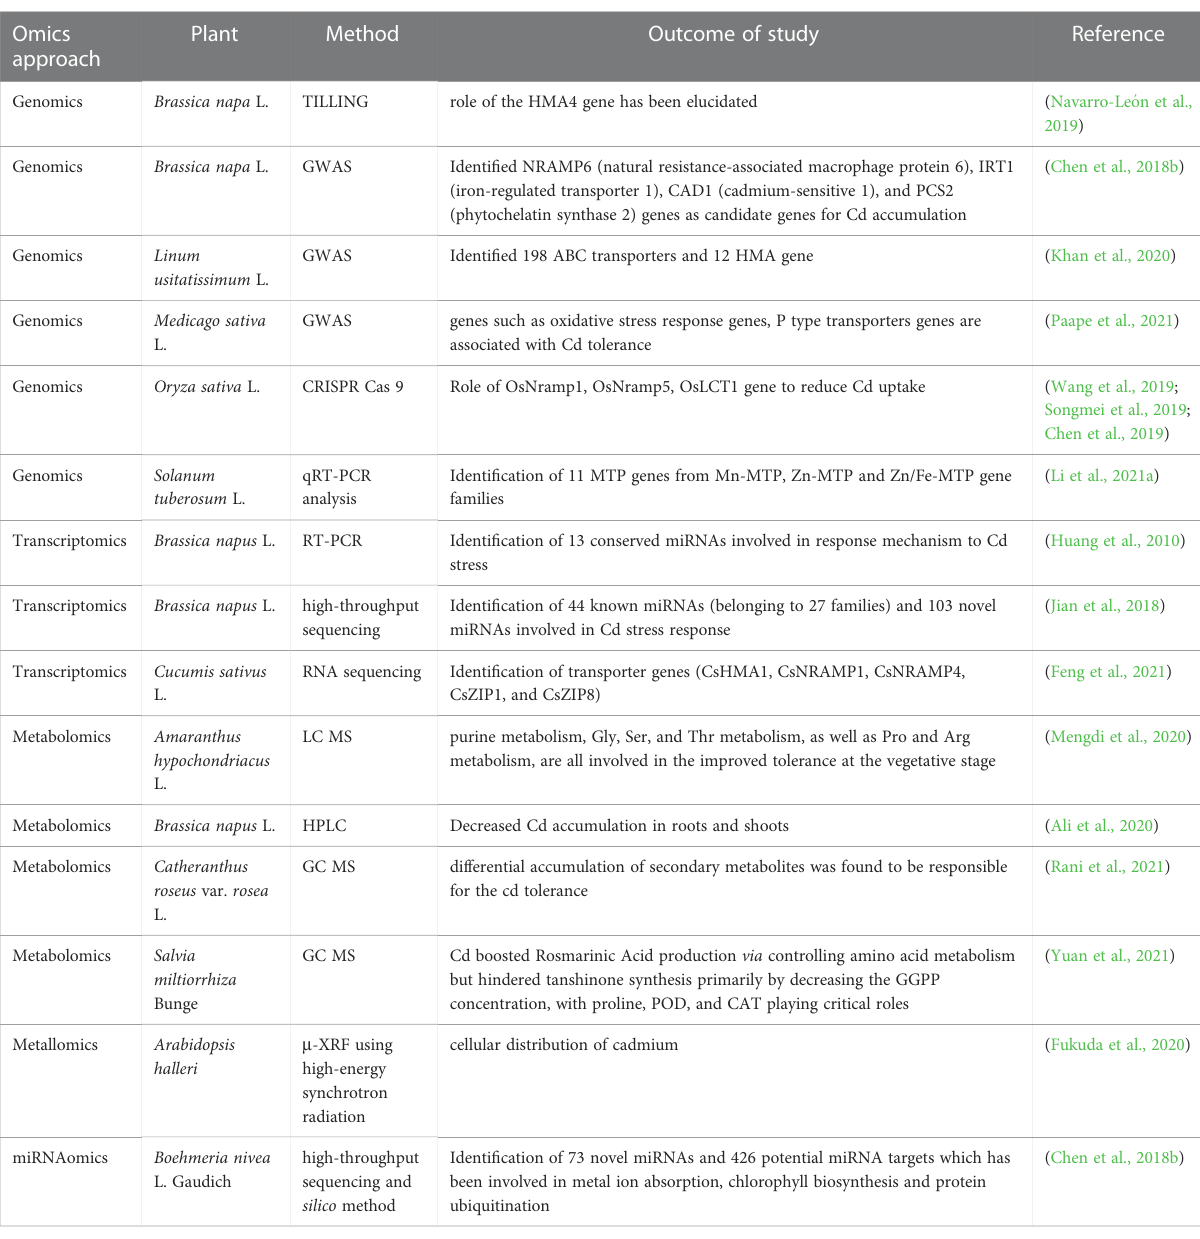
TABLE 6 Omics approaches for understanding response to cadmium stress in medicinal